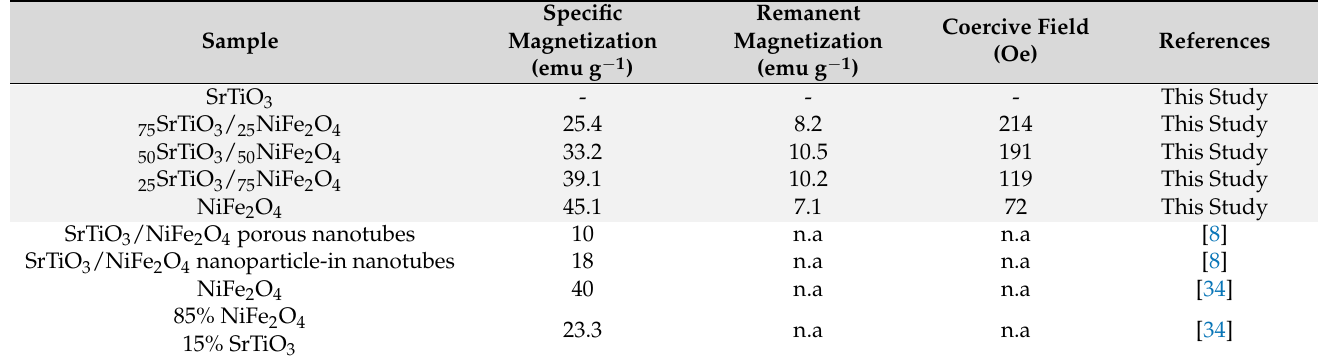
Table 4. Magnetic properties of NiFe 2 O 4 , SrTiO 3 , and SrTiO 3 /NiFe 2 O 4 composites